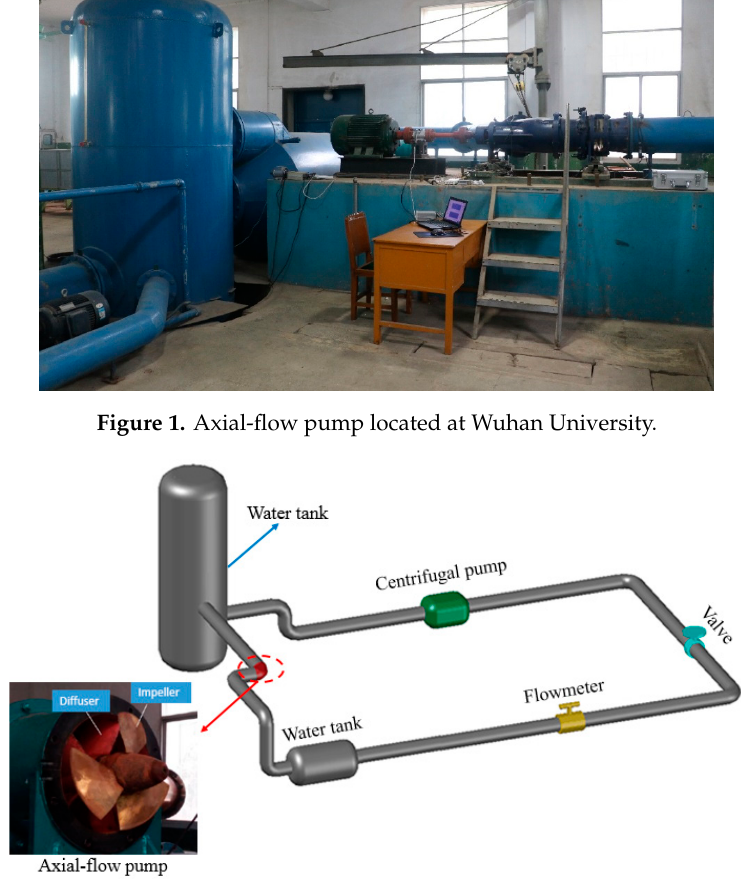
Figure 2. Schematic of the test loop. Table 1. Main parameters of the experimental axial-flow pump